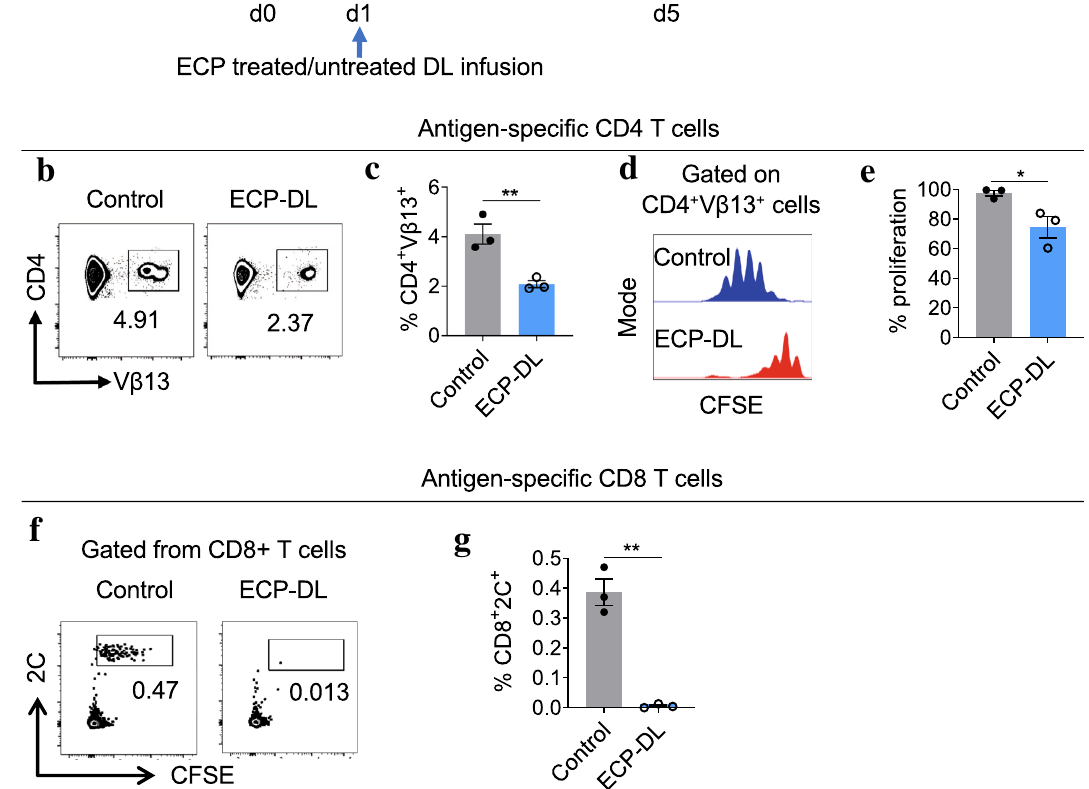
Figure 3. ECP-DL infusion decreases antigen-specific CD4 + and CD8 + T-cells and suppresses their proliferation prior to cardiac transplantation. ( a ) Transgenic B6 mice (4C and 2C) were utilized to evaluate the effect of ECP-DL treatment on alloreactive T-cells. CD4-4C and CD8-2C cells were isolated from transgenic B6 mice and labeled with CFSE; cells were then injected into B6 mice (d0). On day 1, ECP-DL or untreated splenocytes from BALB/c mice were infused. On day 5, recipient mice were sacrificed, and antigen-specific T-cells in the spleen were assessed. N = 3 per group. ( b, c ) Representative dot plots and bar graphs demonstrating antigen-specific CD4 + T-cells (Vβ13 + CD4 + , gated from CD3 + CD4 + T-cells) were significantly lower in the spleen of mice treated with ECP-DL compared to that of the untreated group. ( d, e ) The proliferation of antigen- specific CD4 + T-cells isolated from the spleen was significantly lower in the ECP-DL treated group as measured by the CFSE intensity. ( f, g ) Representative dot plots and bar graphs demonstrating antigen-specific CD8 + T-cells (2C + CFSE + , gated from CD3 + CD8 + T-cells) were significantly lower in the spleen of mice treated with ECP-DL compared to that of the untreated group. Their proliferation rate was not compared as the frequency of 2C + CD8 T-cells in the ECP-DL group was almost undetectable. In c , e , and g , * p < 0.05, ** p < 0.01 by student t